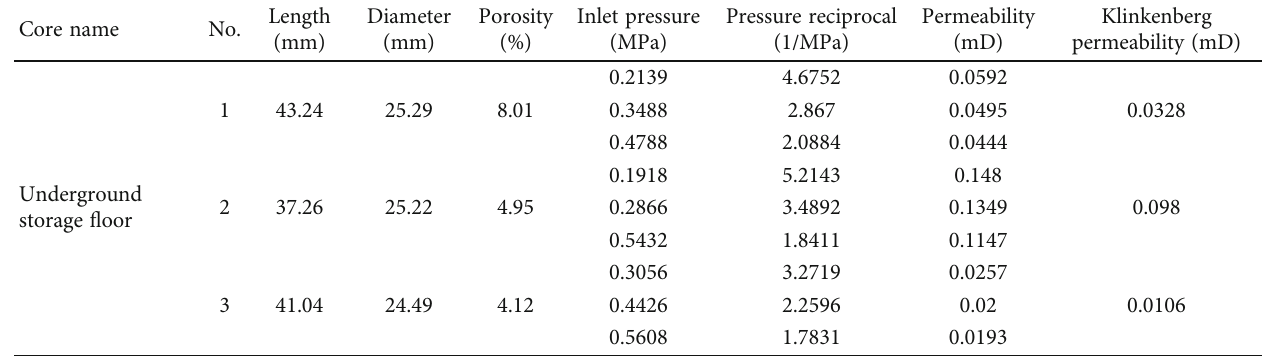
Table 1: Permeability test